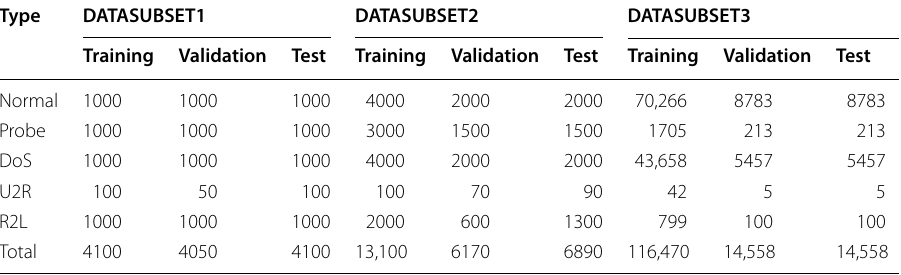
Table 1 Three data subsets of KDD cup 1999